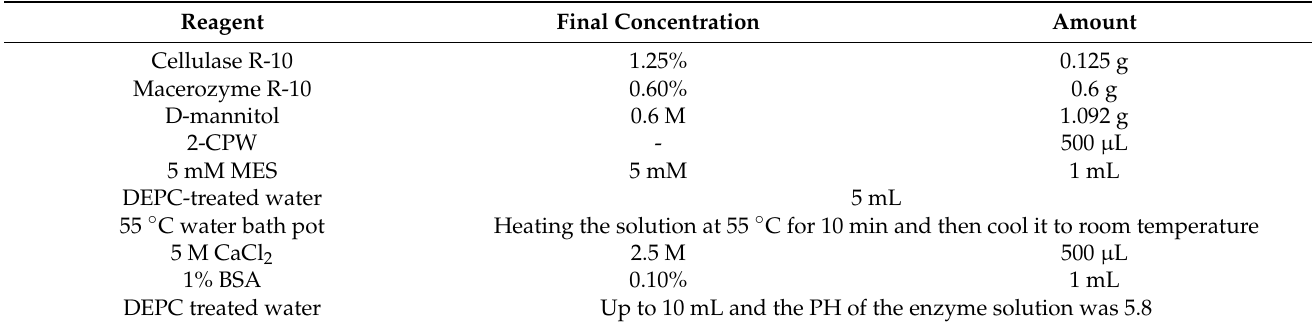
Table 2. Composition of enzymatic hydrolysate (10 mL).